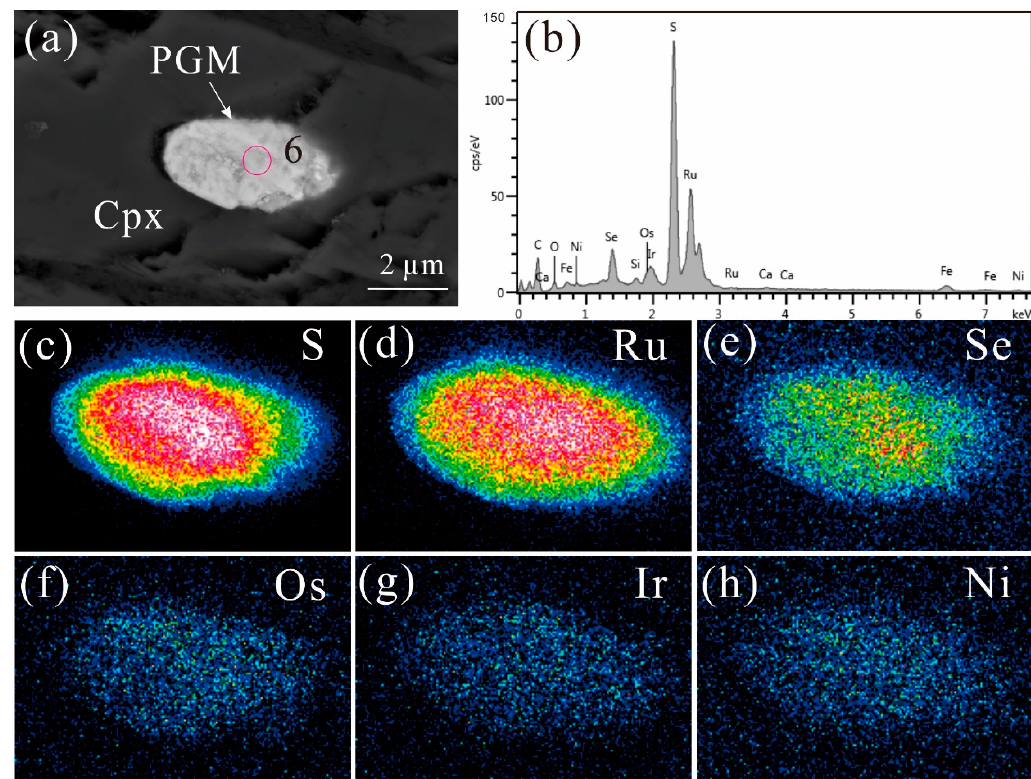
Figure 5. BSE images and S, Ru, Se, Os, Ir, and Ni element maps of a single phase of PGM grain from the silicate matrix of clinopyroxene. ( a ) BSE image; ( b ) the EDS spectrum of spot 6; ( c – h ) S, Ru, Se, Os, Ir, and Ni element maps. Cpx: clinopyroxene; 6: the position of semi-quantitative spot analysis of spot 6 in Table 1.